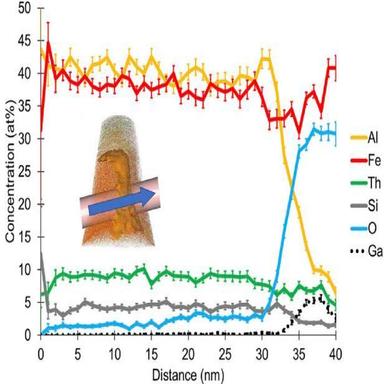
Concentration profile along a 10 nm diameter cylinder as depicted in the inset reconstruction through a 30 at% Al isoconcentration surface separating the metal and oxide.